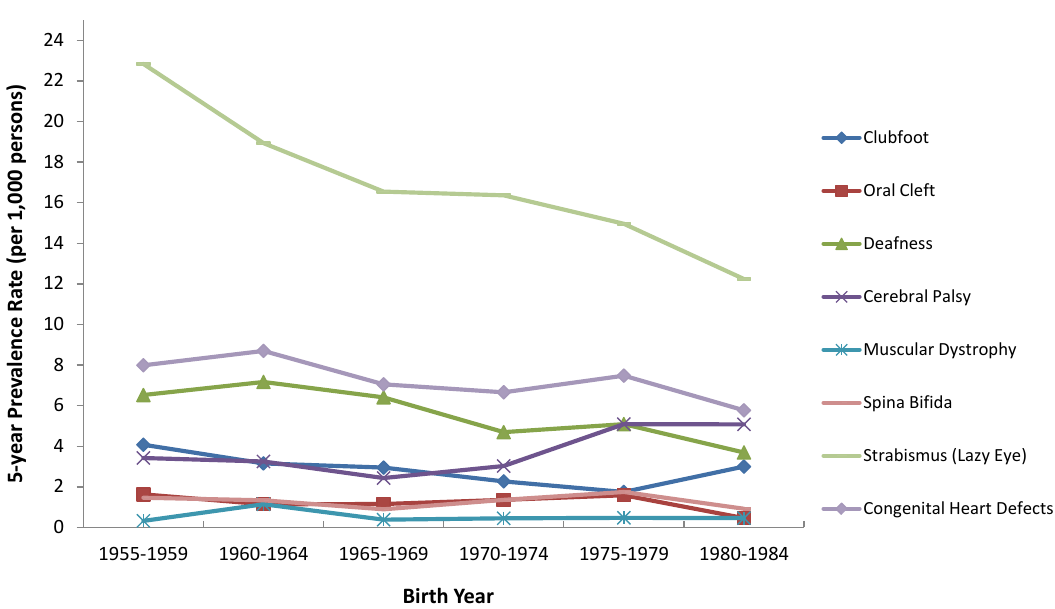
Figure 1. Five-year prevalence rate of selected birth anomalies (per 1,000 persons) in the California Twin Program (Birth cohort 1957 – 1982, N = 20,803